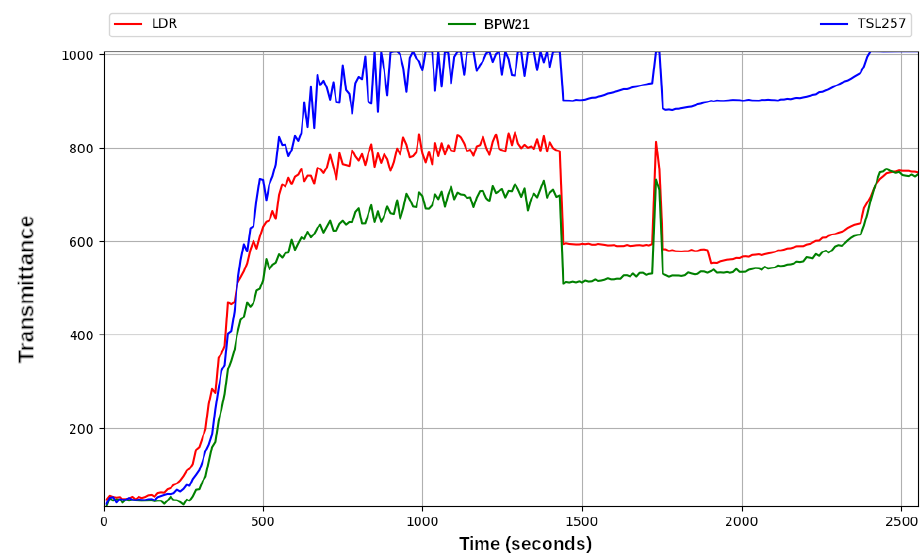
Figure 9. Transmittance behaviour of methyl red dye degradation recorded with three different sensors: LDR (red), BPW21 (green) and TSL257 (blue) without pausing of the stirrer.